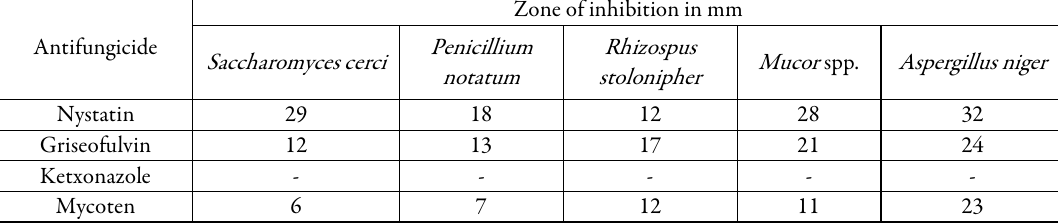
Table 6. Fungal sensitivity test of isolates from bread samples Antifungicide